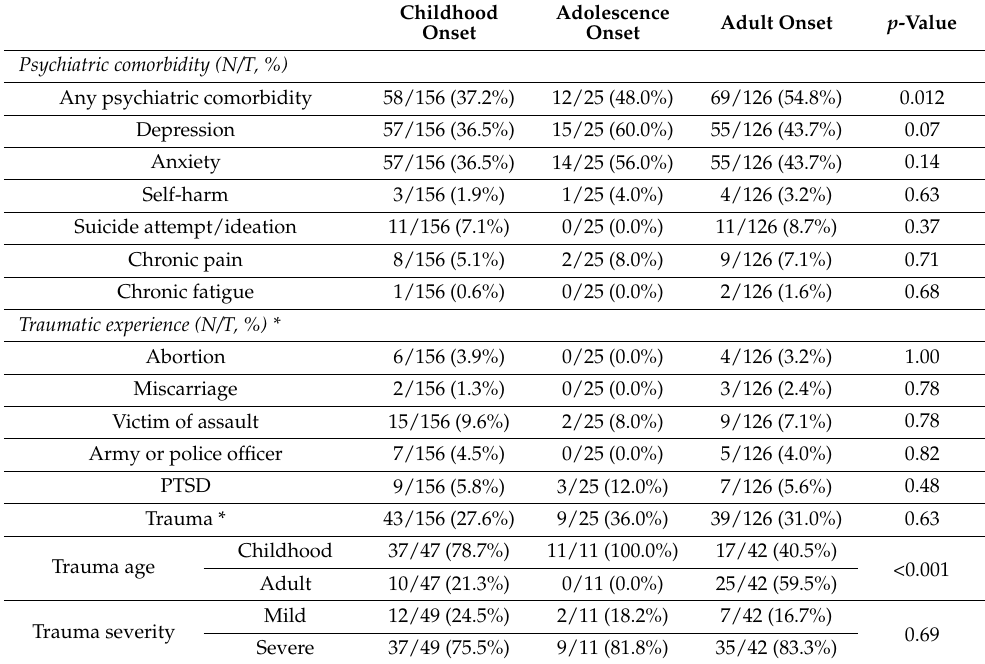
Table 6. Prevalence of psychiatric comorbidities and traumatic experiences in patients with NREM parasomnia split by age of onset ( p at 0.05/3 = 0.017).